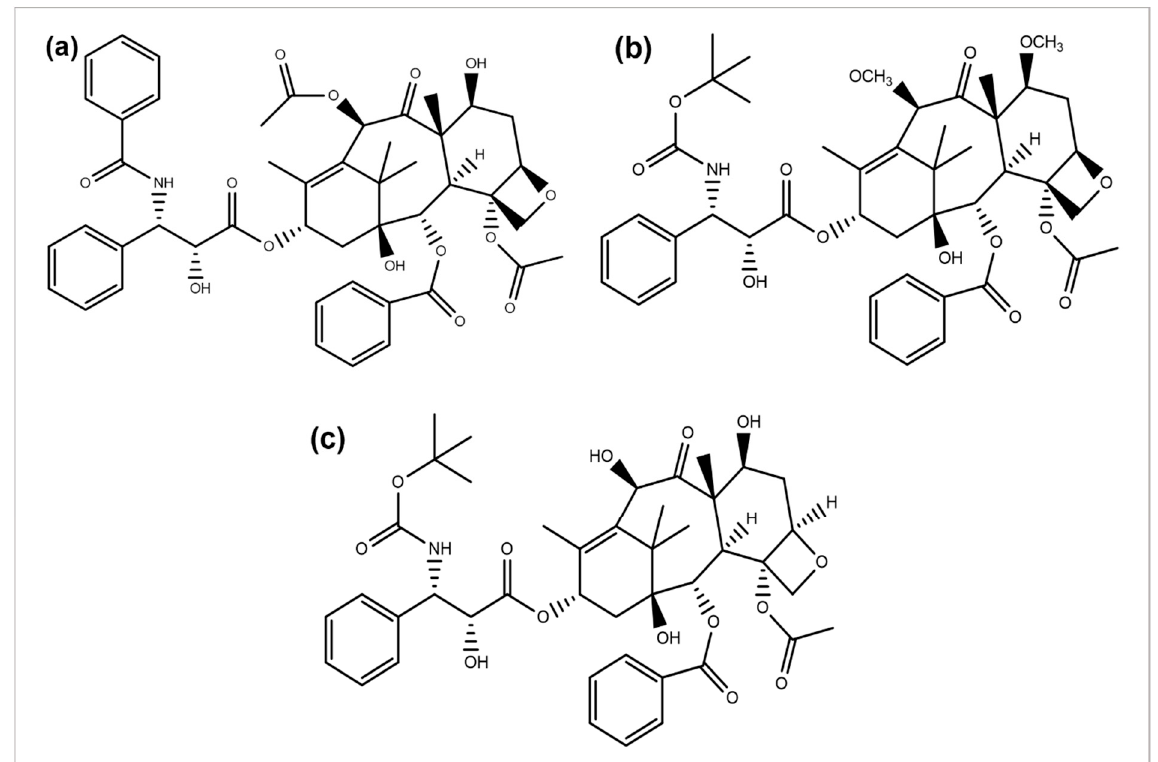
Figure 5. Chemical structures of ( a ) paclitaxel, ( b ) cabazitaxel, and ( c ) docetaxel.